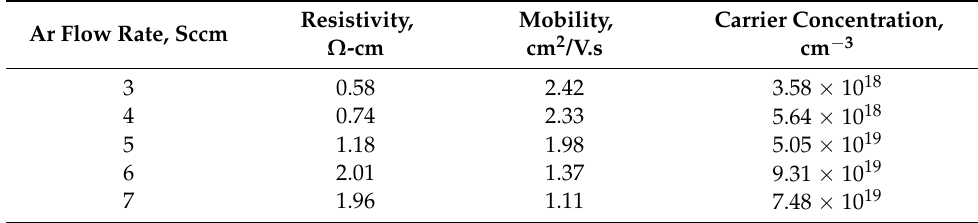
Table A2. Electrical properties of the as-grown WS 2 thin